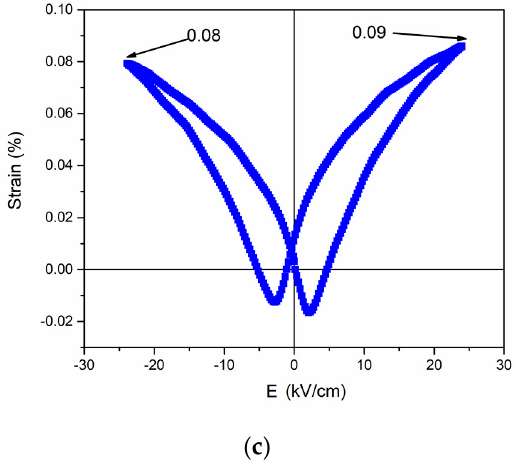
Figure 6. ( a ) Ferroelectric hysteresis loop at 1 Hz of BCTZ8-5 ceramics for the maximum applied field of 30 kV/cm. ( b ) Ferroelectric loops at 1 Hz for BCTZ8-5 ceramic in comparison with BCZT1510 and BCTZ1010 ceramics. ( c ) S-E loop for BCTZ8-5 ceramic.